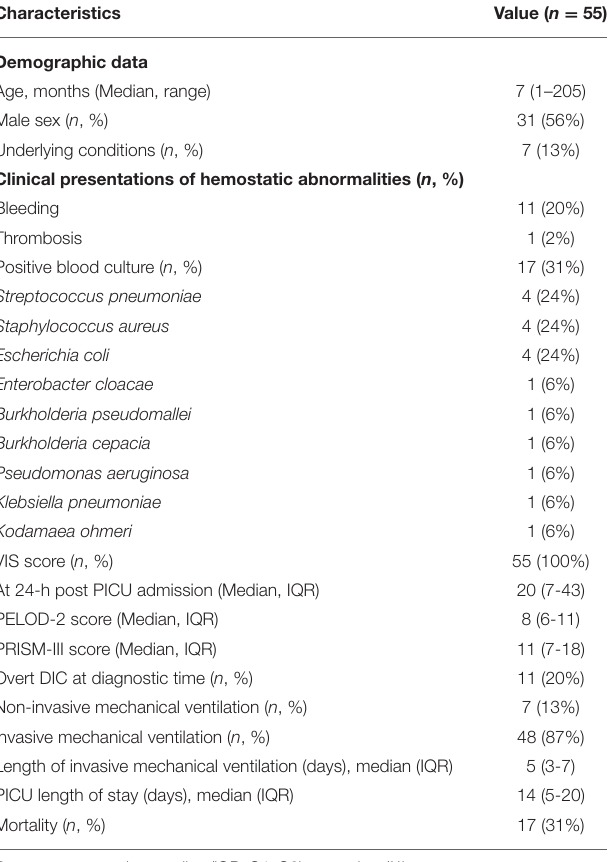
TABLE 1 | Patient